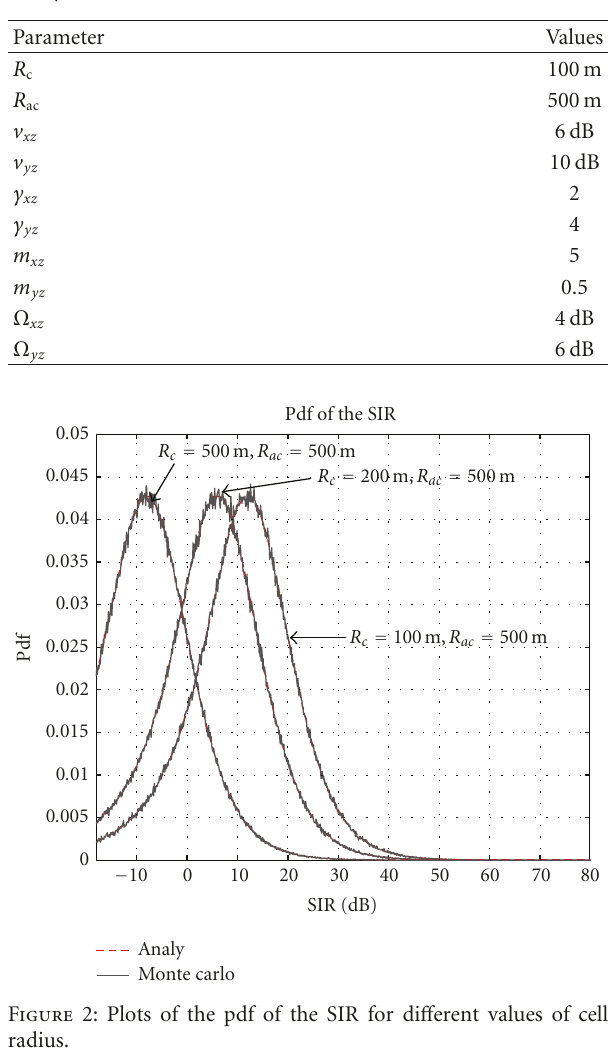
Table 1: System parameters for Figure 2 (varying cell and access- ability radius).